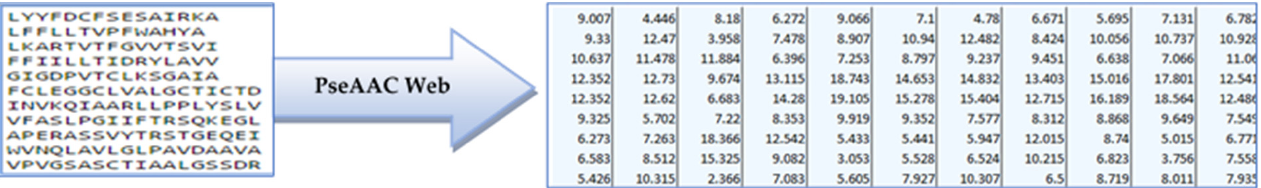
Algorithm1 RSIHSQR FS algorithm Algorithm: RSIHSQR(C,De) Input : C, the conditional attributes; De, the class attribute; Output : Optimal feature subset Step I: The fitness function,f(X) to be defined. Initialize the parameters HMS=30 HMCR = 0.9